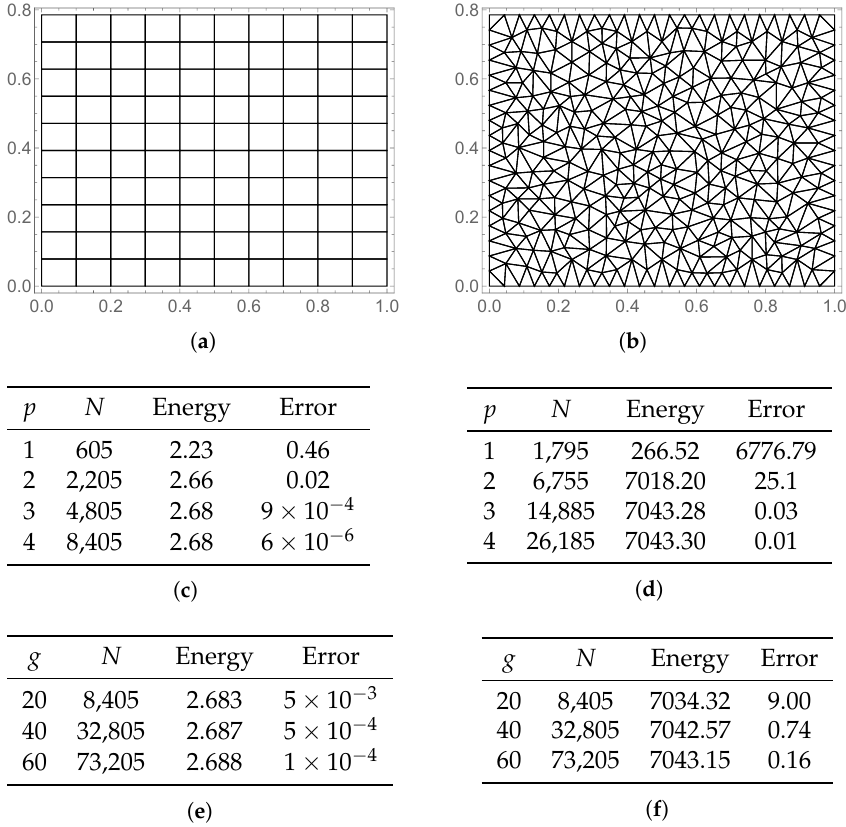
Figure 10. Pitkäranta cylinder, t = 1/100. ( a ) Clamped case on 10 × 10-grid: Mesh. ( b ) Free boundary: Mesh. ( c ) Clamped case on 10 × 10-grid: Errors. Squared energy norm convergence (absolute error) in p = 1, . . . ,4 using different discretisations. ( d ) Free case: Errors. Squared energy norm convergence (absolute error) in p = 1, . . . ,4 using different discretisations. ( e ) Clamped case on g × g -grid: Errors. Squared energy norm convergence (absolute error) at p = 2 over a series of uniform discretisations. ( f ) Free case on g × g -grid: Errors. Squared energy norm convergence (absolute error) at p = 2 over a series of uniform discretisations. N is the number of degrees of